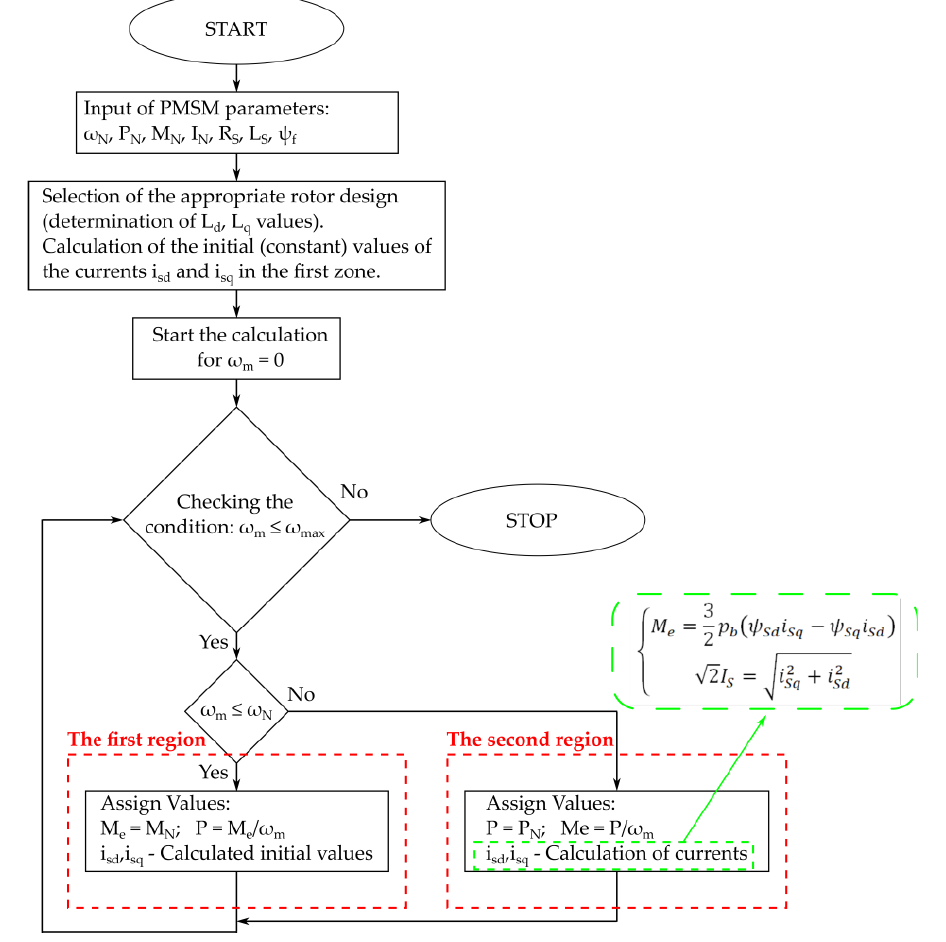
Figure 5. Algorithm for 𝑖 𝑆𝑑 , 𝑖 𝑆𝑞 calculation of PMSM.